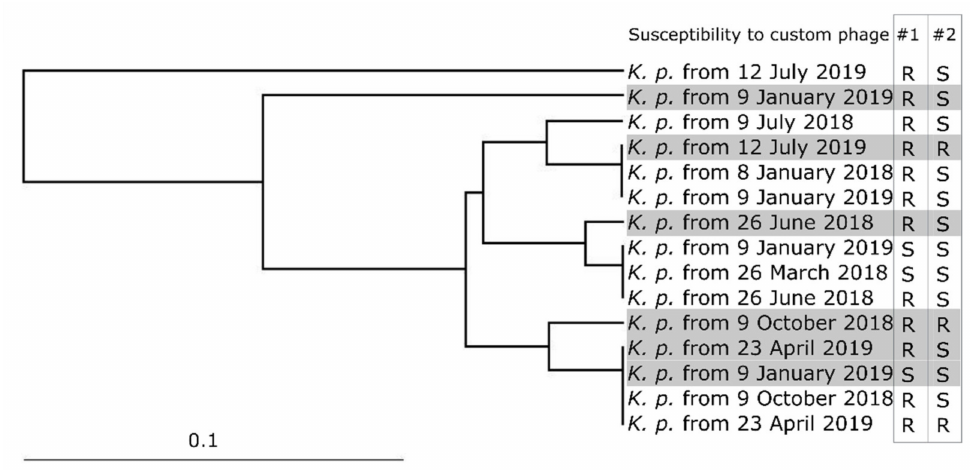
Figure 3. Clustering of Klebsiella pneumoniae strains of patient #3. Vaginal isolates are boxed in grey. Susceptibility to custom phages is shown across the isolation date of each strain. Cluster 1: K. p. (vaginal isolate) from 12 July 2019, K. p. from 8 January 2018, K. p. from 9 January 2019. Cluster 2: K. p. from 9 January 2019, K. p. from 26 March 2018, K. p. from 26 June 2018. Cluster 3: K. p. from 23 April 2019 (vaginal isolate), K. p. from 9 January 2019 (vaginal isolate), K. p. from 9 October 2018, K. p. from 23 April 2019.